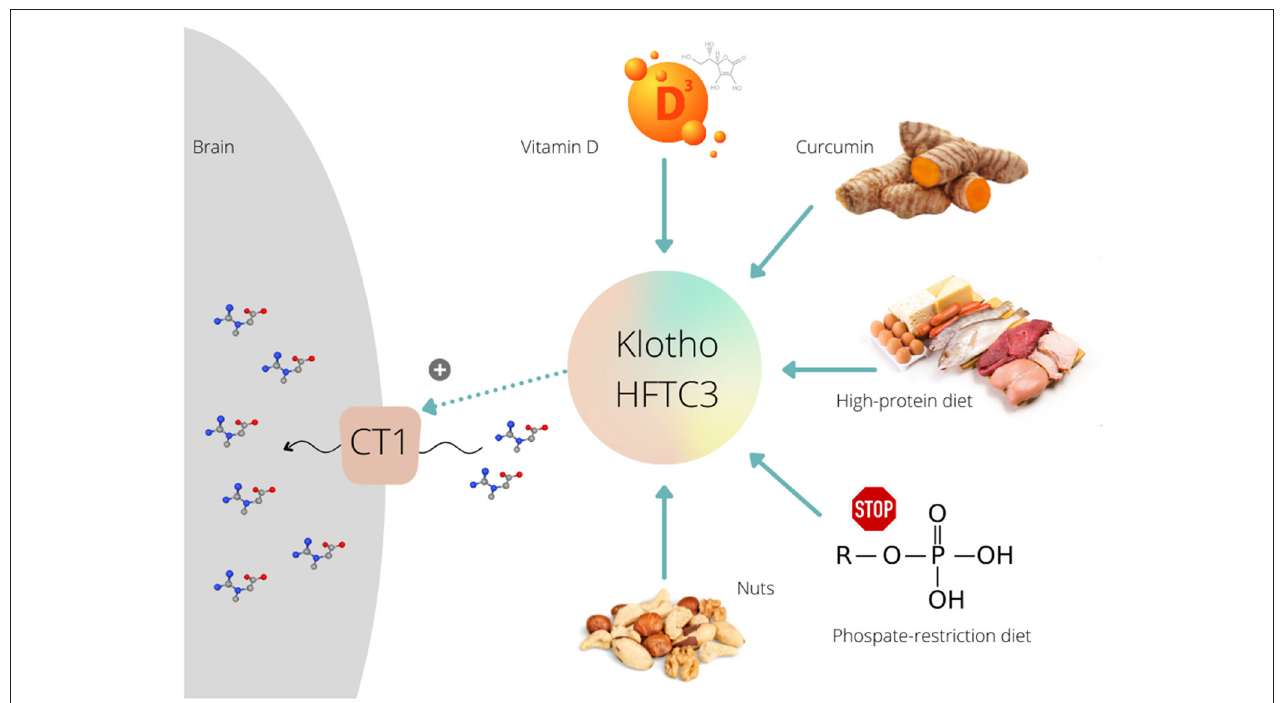
FIGURE 1 | Various dietary interventions upregulate Klotho protein expression/activity that further can stimulate ( + ) creatine uptake via creatine transporter (CT1) in the